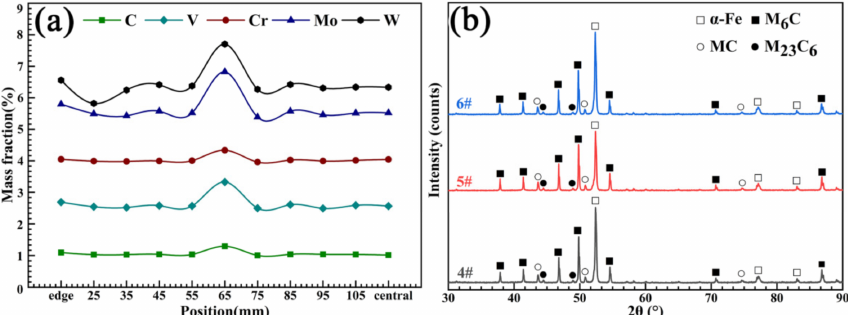
Figure 4. ( a ) The composition test of sample #1 and ( b ) the XRD patterns of samples #4, #5, and